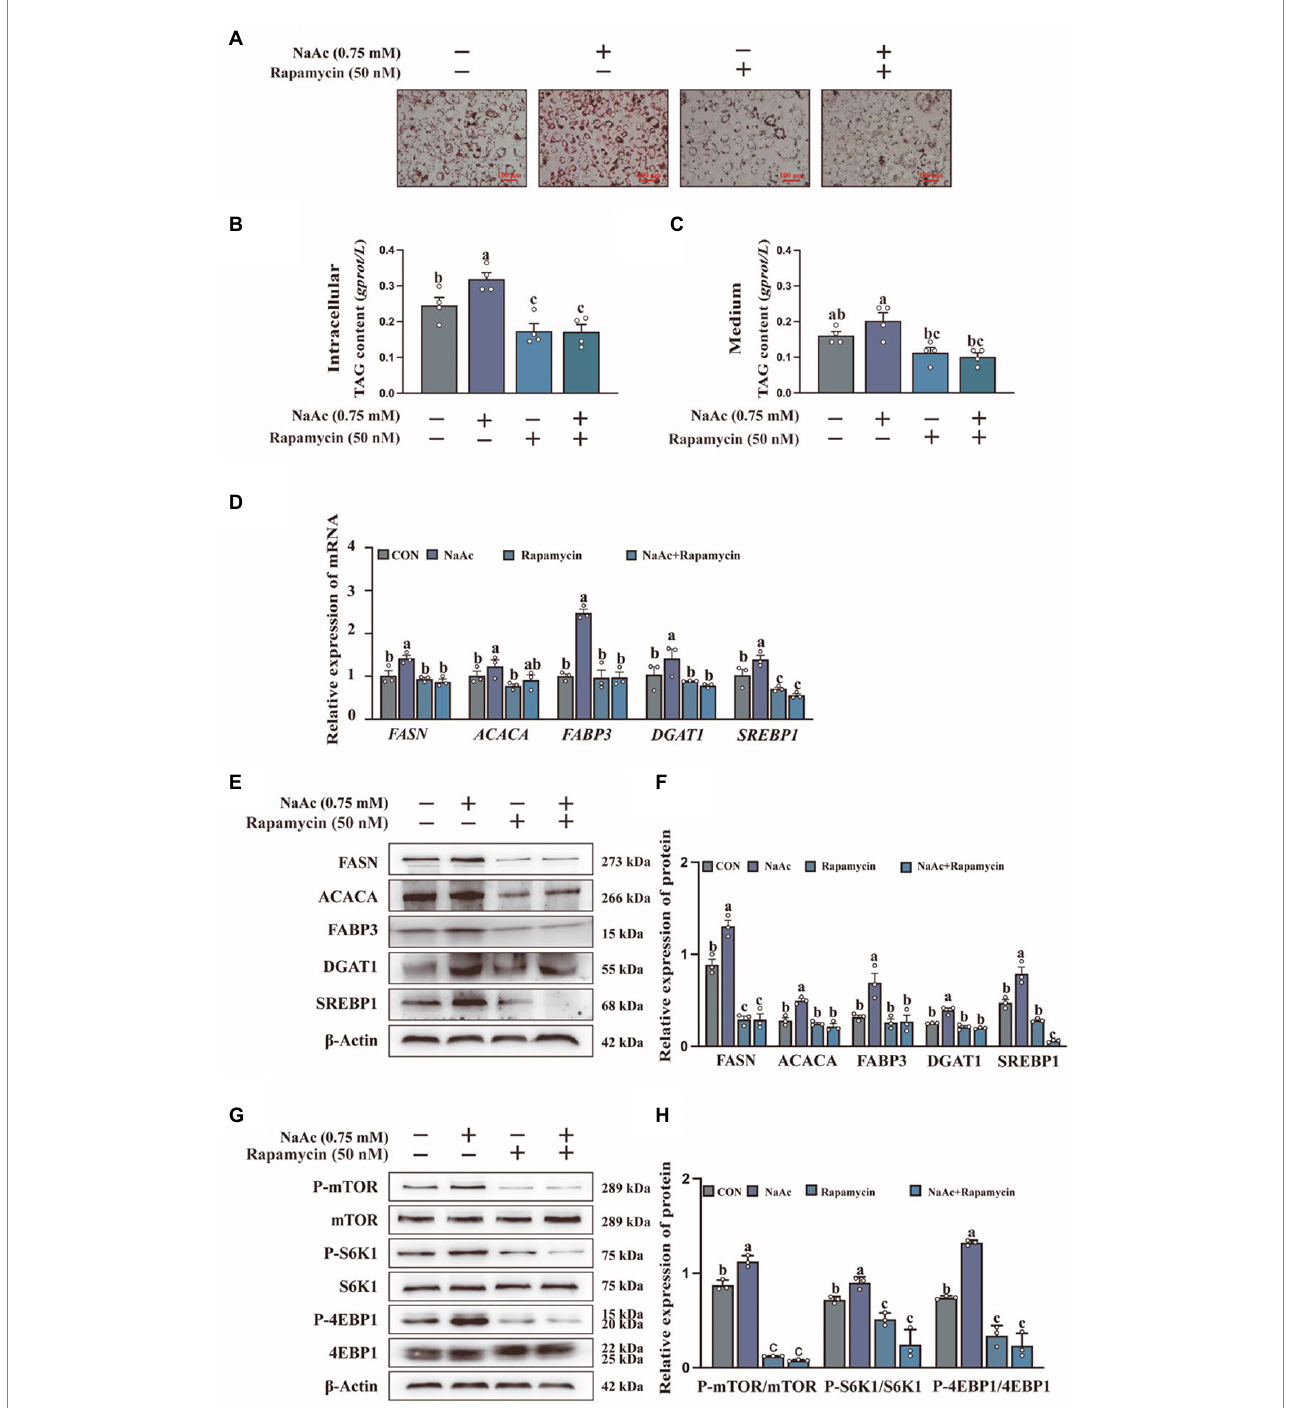
FIGURE 3 Effect of sodium acetate (NaAc) on milk fat synthesis and mTORC1 activation after pretreated with rapamycin. HC11 cells used in this figure were pre- treated for 2 h with 50 nM rapamycin (mTOR inhibitor) before incubation with 0.75 mM NaAc for 24 h. (A) Oil red O staining images of HC11 cells. Scale bars are 100 μ m. TAG content in intracellular (B) and medium (C) . (D) Relative mRNA expression abundance of genes related to milk fat synthesis. (E–H) Relative expression abundance of proteins related to milk fat synthesis and mTORC1 pathway. All data with error bars are averages ± SEM ( n = 3). In histograms, no letter or the same letter above the bar graph indicates no significant difference ( p > 0.05), and different letters indicate a significant difference ( p < 0.05). Each small white dot represents a test